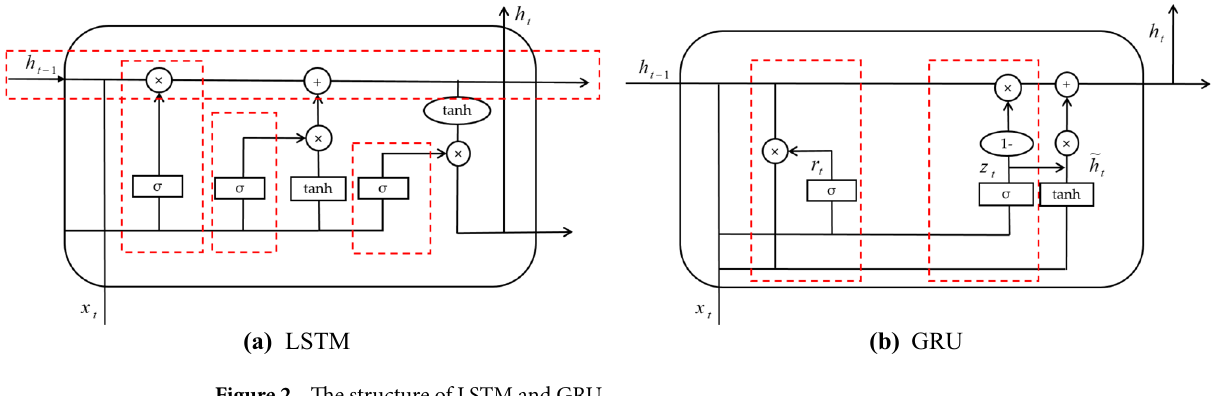
Figure 2. The structure of LSTM and